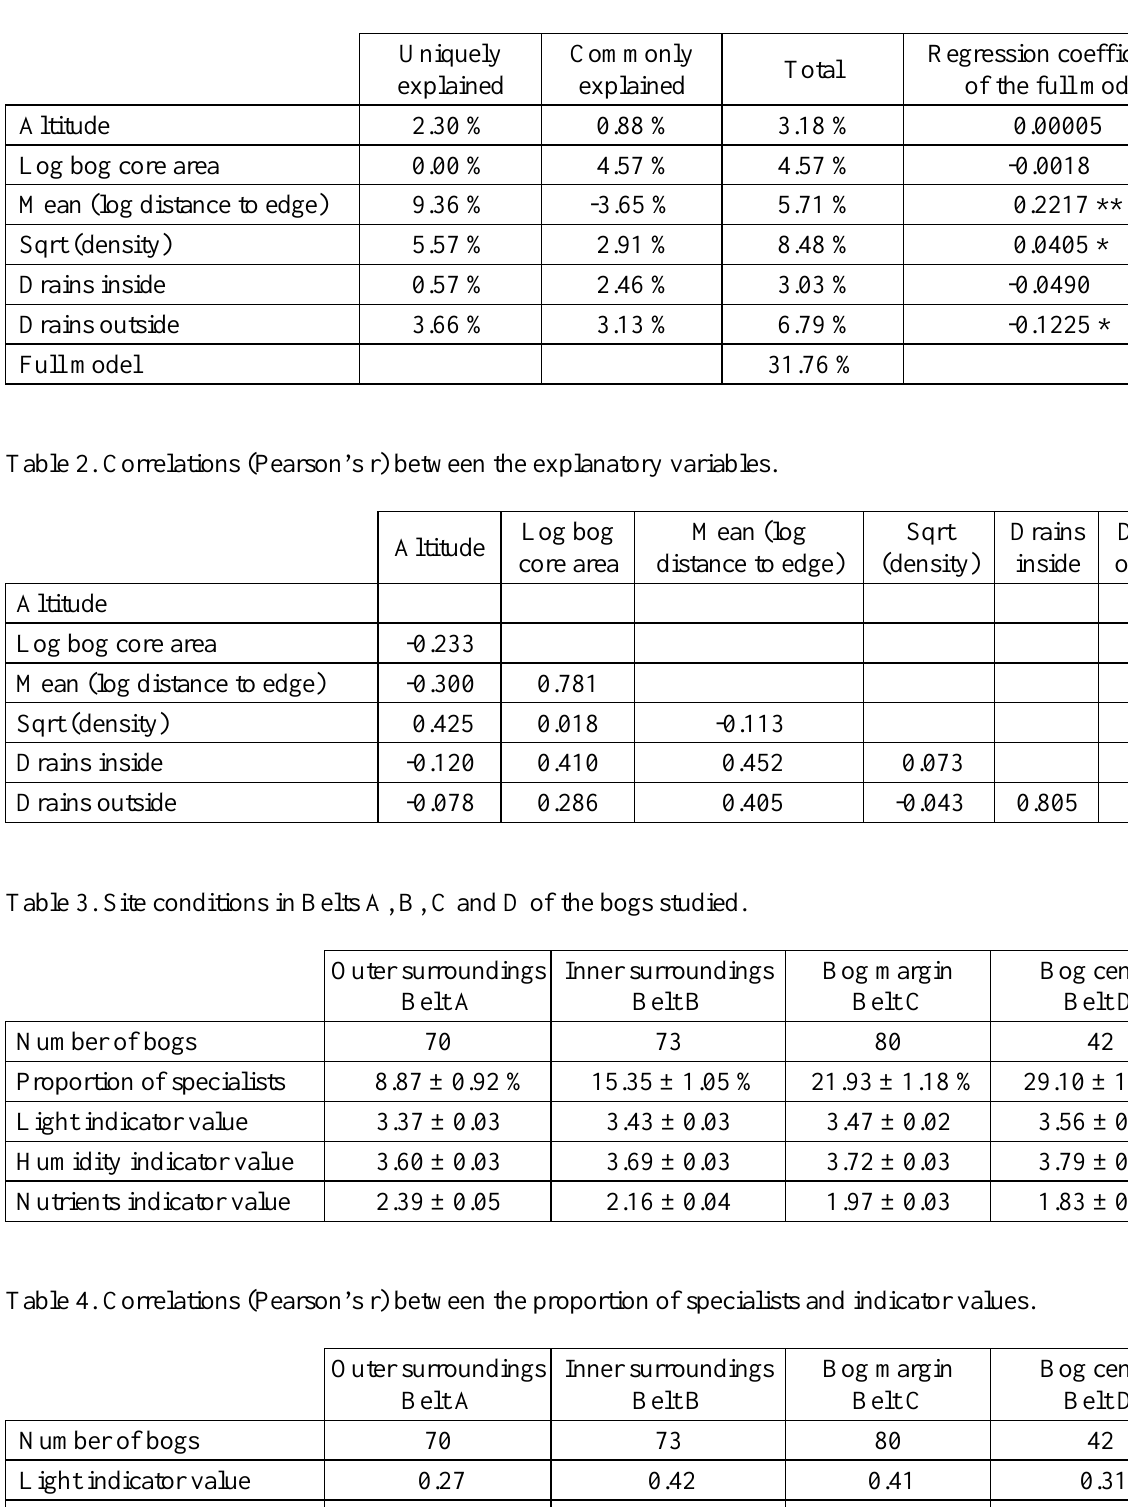
Table 1. Commonality coefficients and regression coefficients of the six explanatory variables considered for the proportion of bog specialist species. Data: values from 80 bog cores. Significance levels for the regression coefficients: ** <0.01, * <0.05.